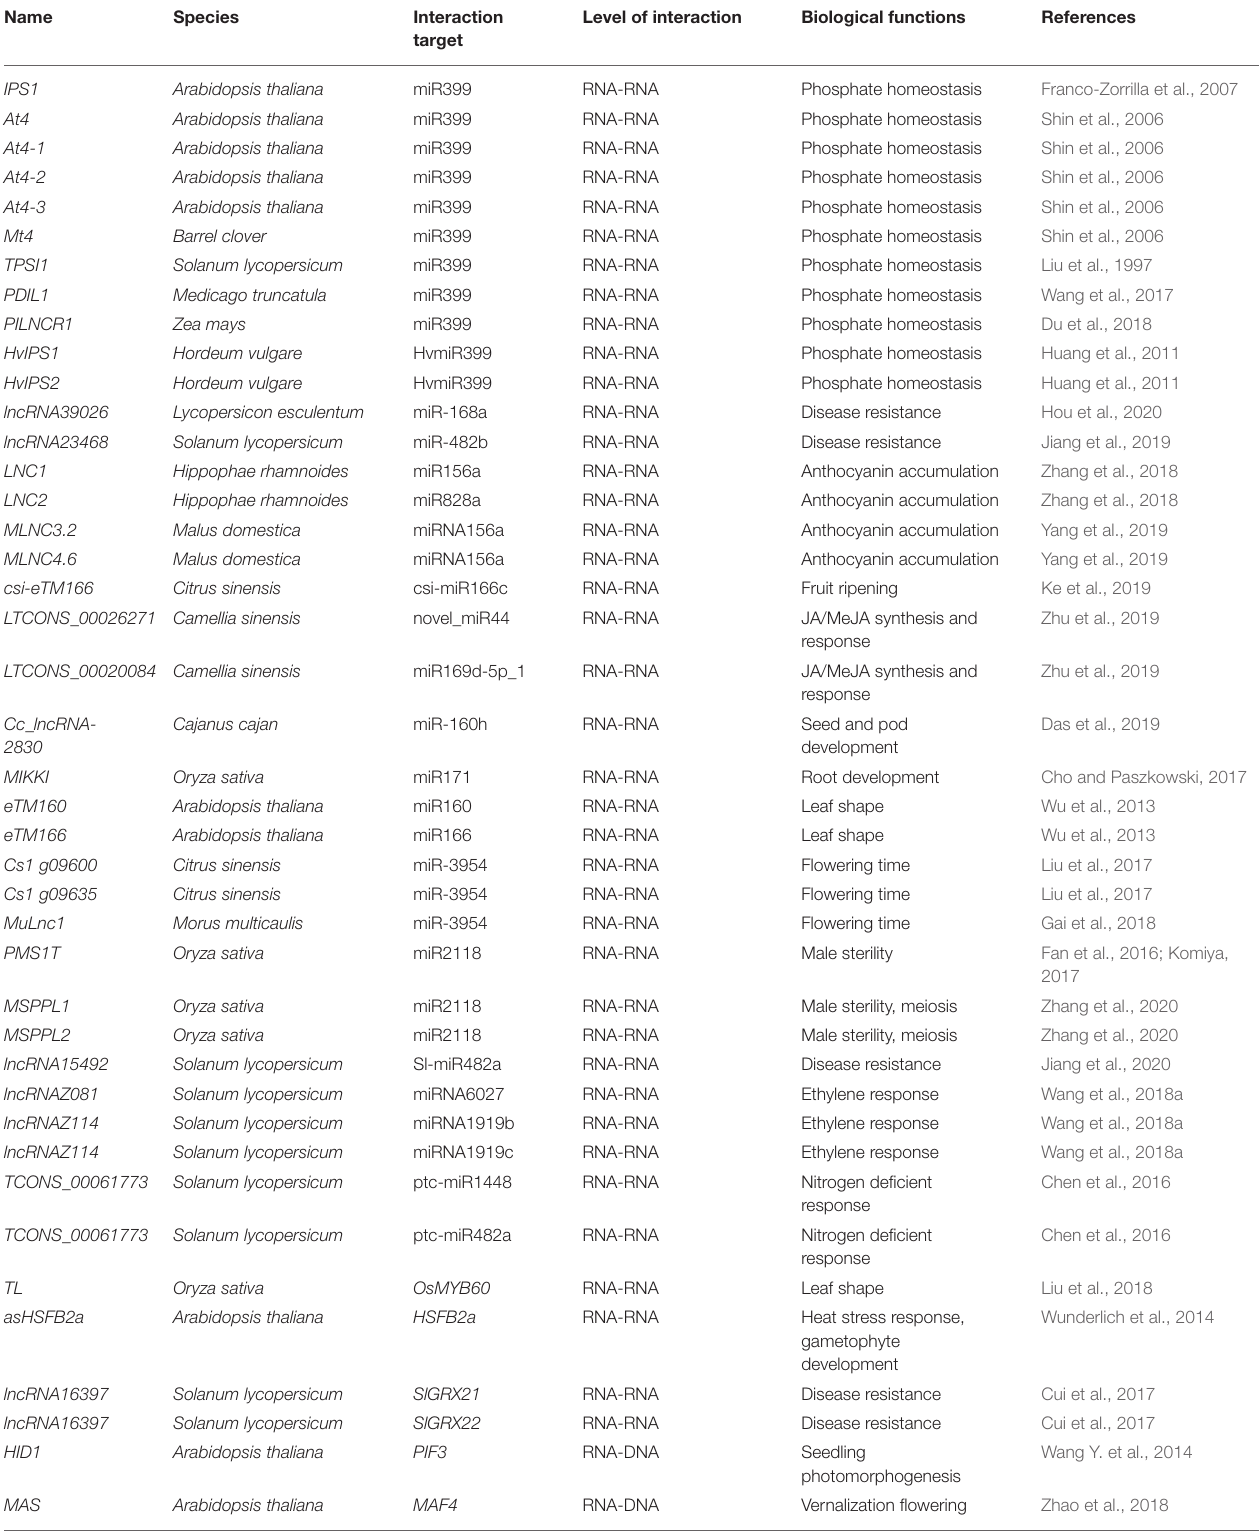
TABLE 1 | Functionally validated lncRNAs and their binding partners in